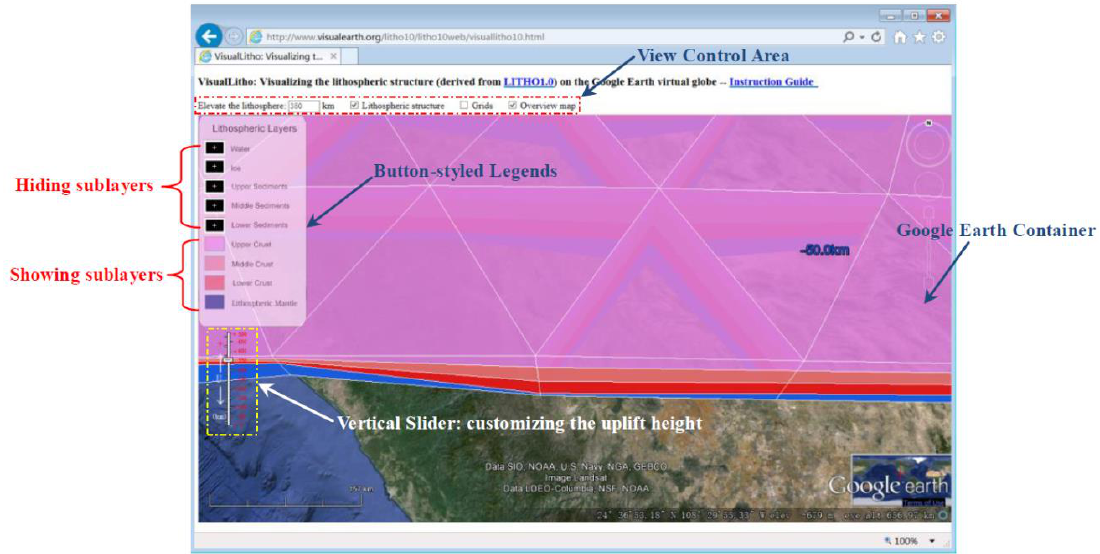
Figure 5. User interface of VisualLitho. In this figure, the top five sublayers (from water to lower sediments) have been unchecked in the legend; consequently they disappear from the view. In addition, the uplifted height is set to the default value (350 km).